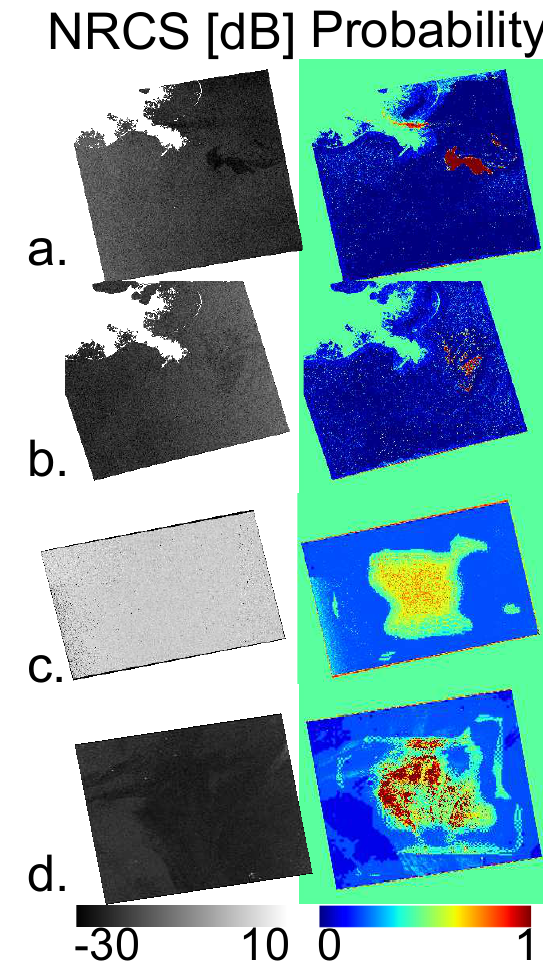
Figure 5: Joint probabilities for the imagery processed in this study. a)Radarsat-2 27-Apr, b)Radarsat-2 01-May, c)Alos 01- May, d)Alos 04-May. Alos results are enlarged for